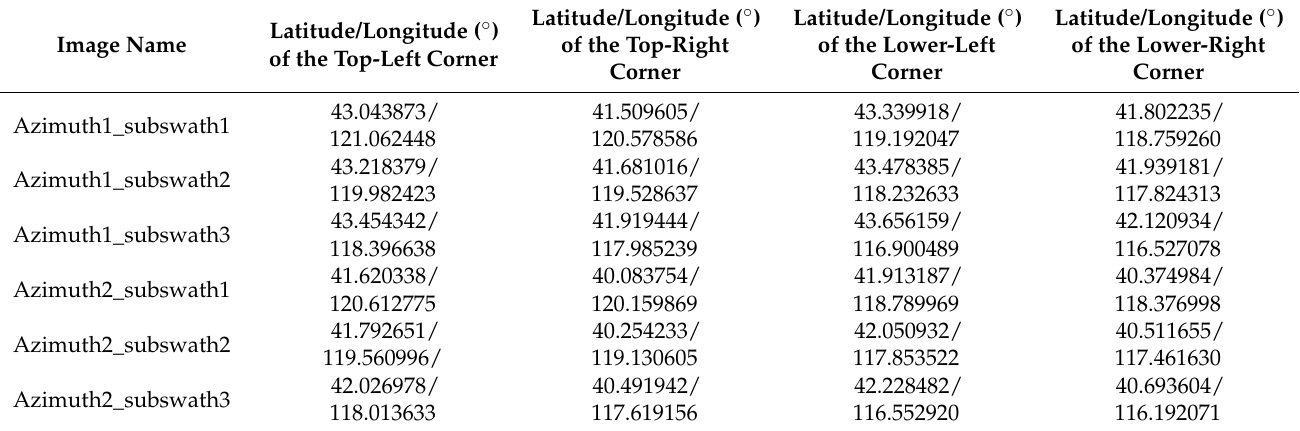
Table 5. Geolocation results of the six GF-3 ScanSAR